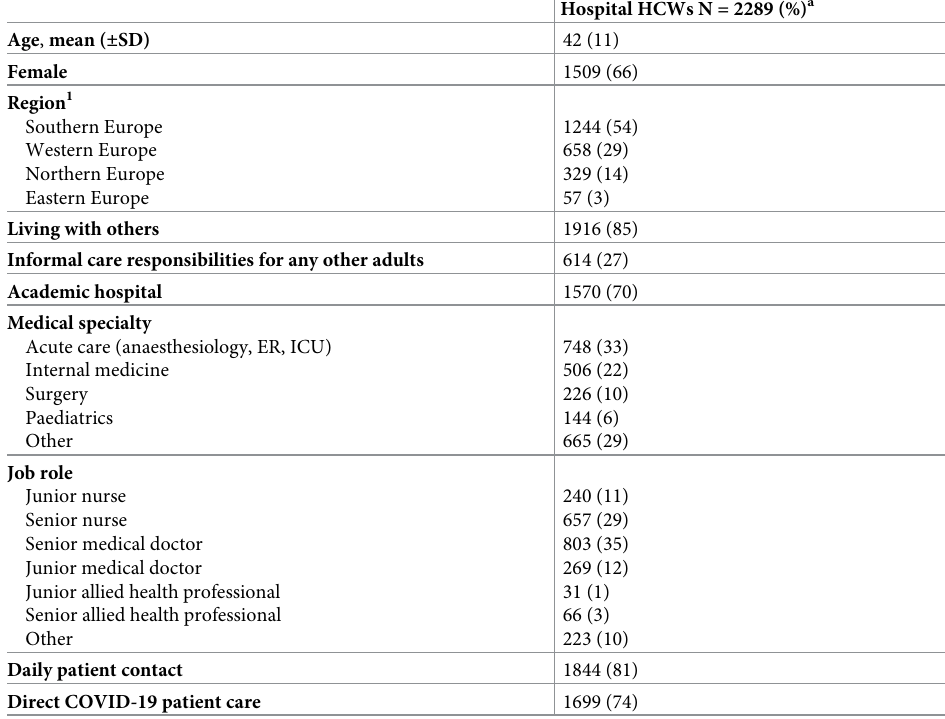
Table 1. Demographic information of all participating hospital health care workers